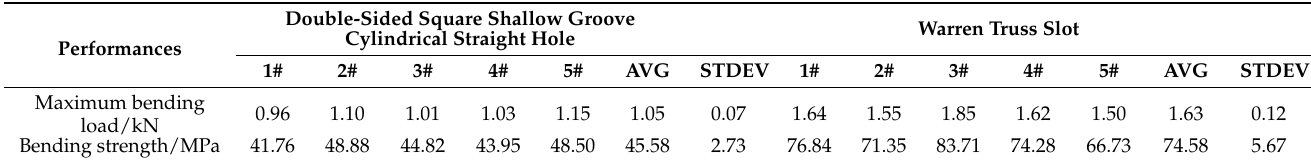
Figure 26. Load–displacement curves of the slotted resin-reinforced sandwich composites ( a ) and ( b ) during the bending test. Table 6. Bending test results of the slotted resin-reinforced sandwich composite core test samples.